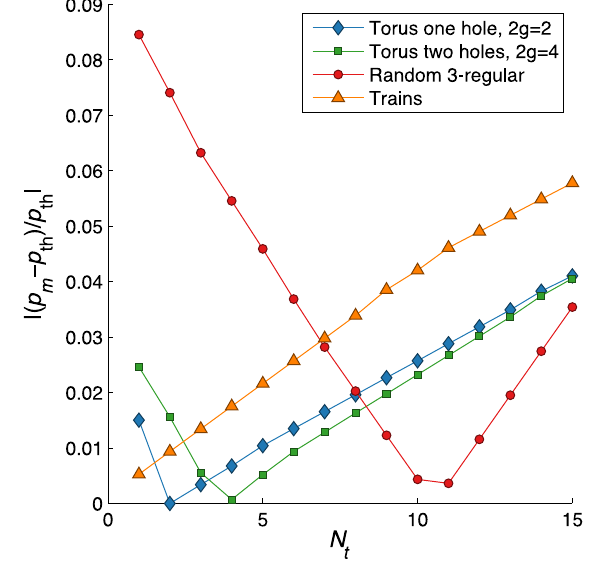
FIG. 10. A comparison of p , the observed average number of m links per cycle upon removing the N largest cycles from the set, t and p , the theoretically predicted value for the given network th − p = 2 . When j p with genus g ¼ N is identically zero, there t m th j is an exact match between the removed cycles and the “ true ” topological cycles. In cases where zero is not achieved, there is some mixing of tiles and topological cycles somewhere in the N -removed cycles. This mixing occurs statistically among the t smallest of the removed cycles. Even so, the minimum of this value indicates that many of the cycles are identified correctly. FIG. 9. Raw, untransformed basis vector length counts (left column, green histograms) and the result of rotating these vectors onto the minimal weight basis (right column, orange histograms). Histograms are shown for a network on a torus ð a , a network on i Þ a 2-torus ð b , a network randomly embedded into space ð c , and i Þ i Þ a real transport network ð d i Þ